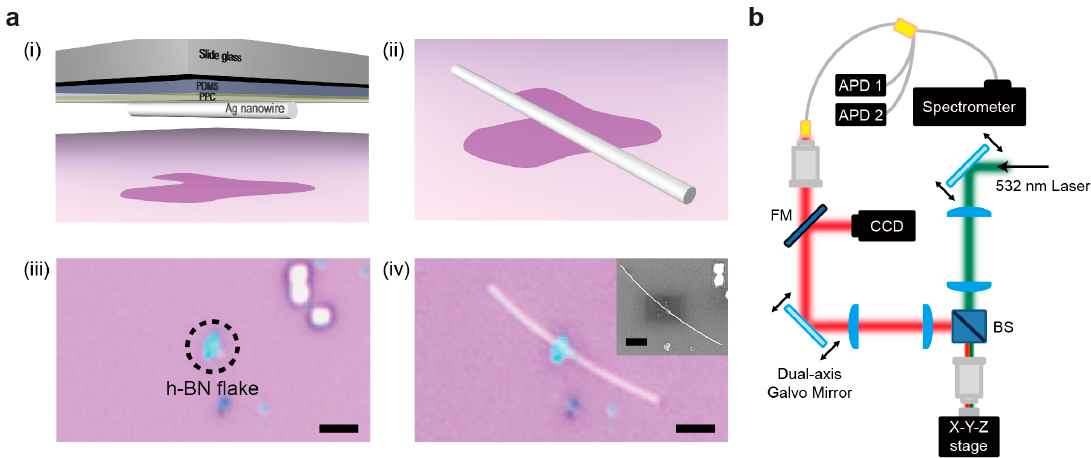
Figure 4. Positioning the Ag nanowire. ( a ) Precise positioning of the Ag nanowire onto the h-BN flake. (i,ii) Schematics of the poly(dimethylsiloxane) (PDMS) / poly(propylene carbonate) (PPC) stamping method. The Ag nanowire dispersed on the PPC / PDMS (i) was aligned and transferred to the h-BN flake (ii). (iii,iv) Optical microscope images of the h-BN flake before (iii) and after (iv) transferring the Ag nanowire. The inset in (iv) shows the scanning electron microscopy (SEM) image of the fabricated sample. Scale bar, 2 µ m. ( b ) Schematics of confocal microscope measurement setup with two sets of galvo mirrors. Excitation of samples and PL scanning measurements were performed independently.